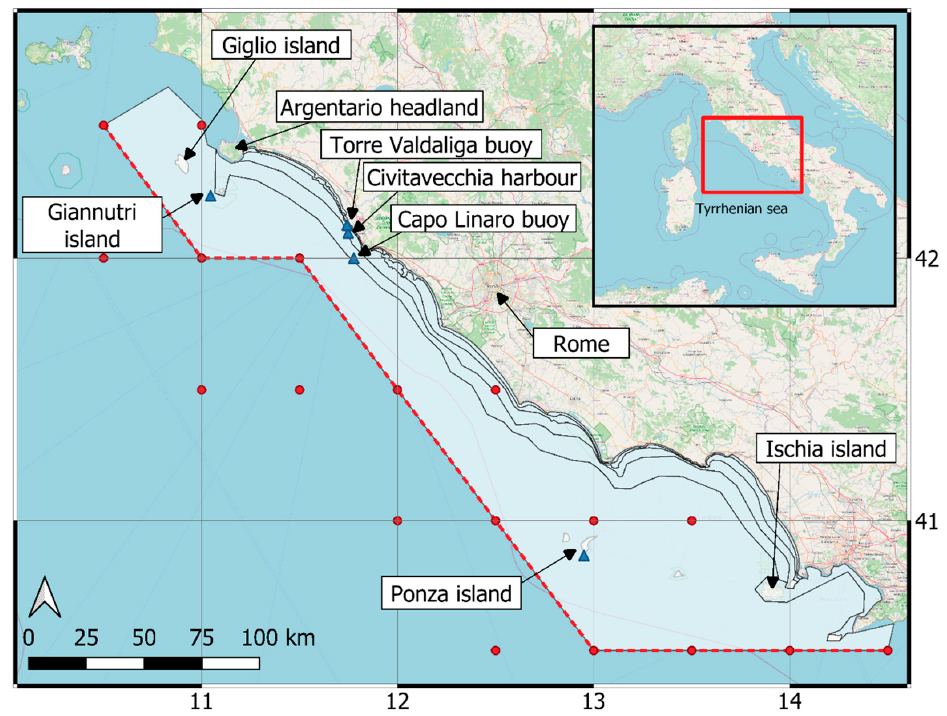
Figure 1. Geographical area of interest. The white area represents the computational domain of the SWAN (simulating waves in the nearshore) model, red dots the nodes where the ERA5 data are available, blue triangles the location of the wave buoys used. Simplified bottom contour lines for water depths of − 10, − 20, − 50, − 100 m are also shown.